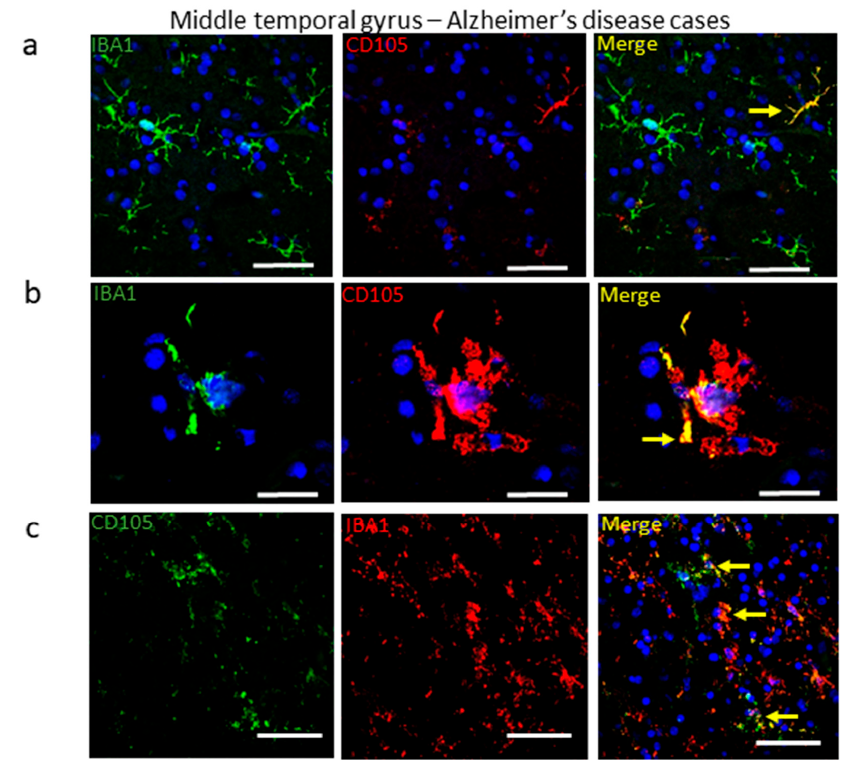
Figure 5. Di ff erent patterns of colocalization of CD105 / MAB1097 and IBA-1 in microglia in AD cases by confocal microscopy. ( a ) IBA-1-positive (green) microglia; CD105-positive immunoreactive cells (red); Merged image showing colocalized CD105 and IBA-1 (yellow). Blue identifies nuclei revealed by staining with DAPI. Scale bars represent 50 µ m. ( b ) Higher magnification image of a single cell with activated morphology. IBA-1-positive (green) microglia, strongly staining CD105-positive microglia with activated morphology (red). Merged image showing colocalized signals (yellow) within cell. Scale bars represent 25 µ m. ( c ) Images to show di ff erent amounts of CD105 expression in microglia in an AD case. CD105 immunoreactivity (green), IBA-1 immunoreactivity (red), and merged image (yellow). Scale bars represent 50 μ m.